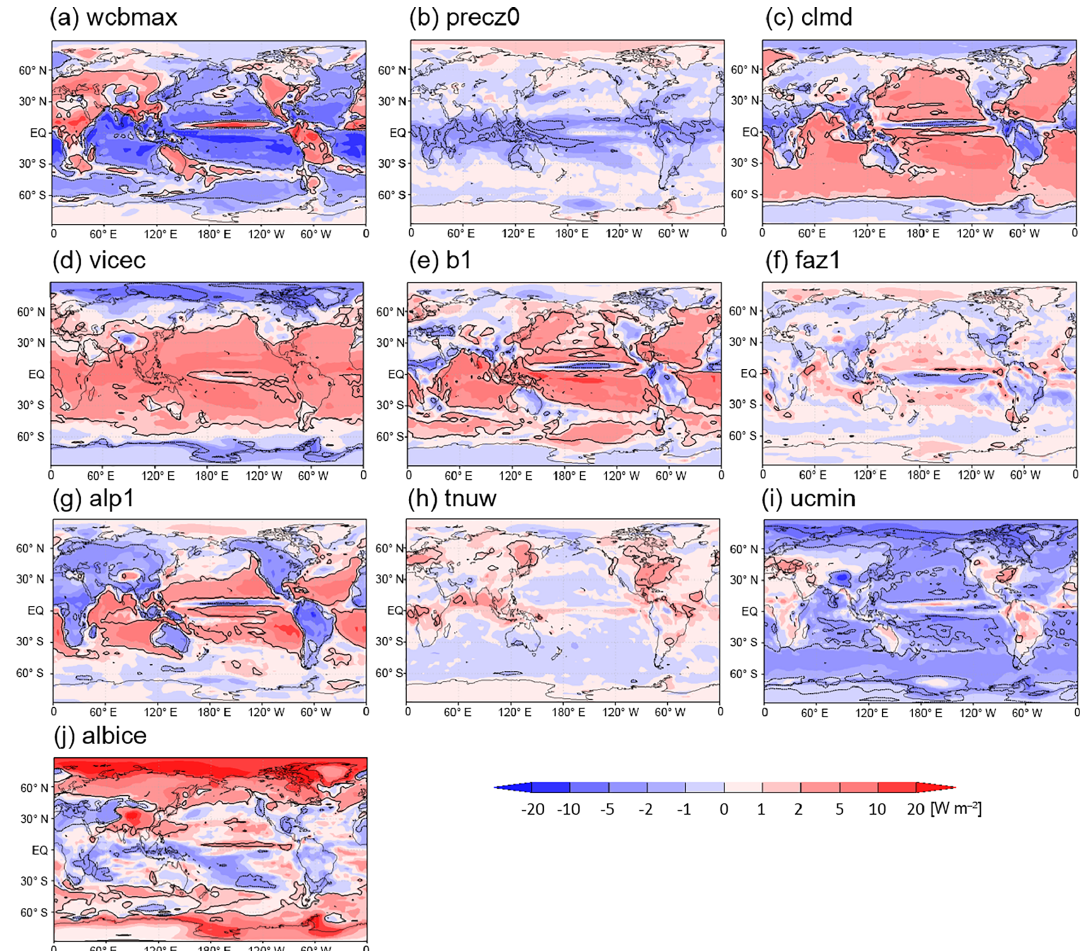
Figure 7. Regression coefficient of the annual mean TOA shortwave CRE on the tuning parameters calculated with the 56 samples of the MIROC5 PPE. The definition of the tuning parameters is shown in Table 1. The tuning parameters are normalized to the range of [0,1]. The black curves indicate the threshold of the statistical significance with the 5%